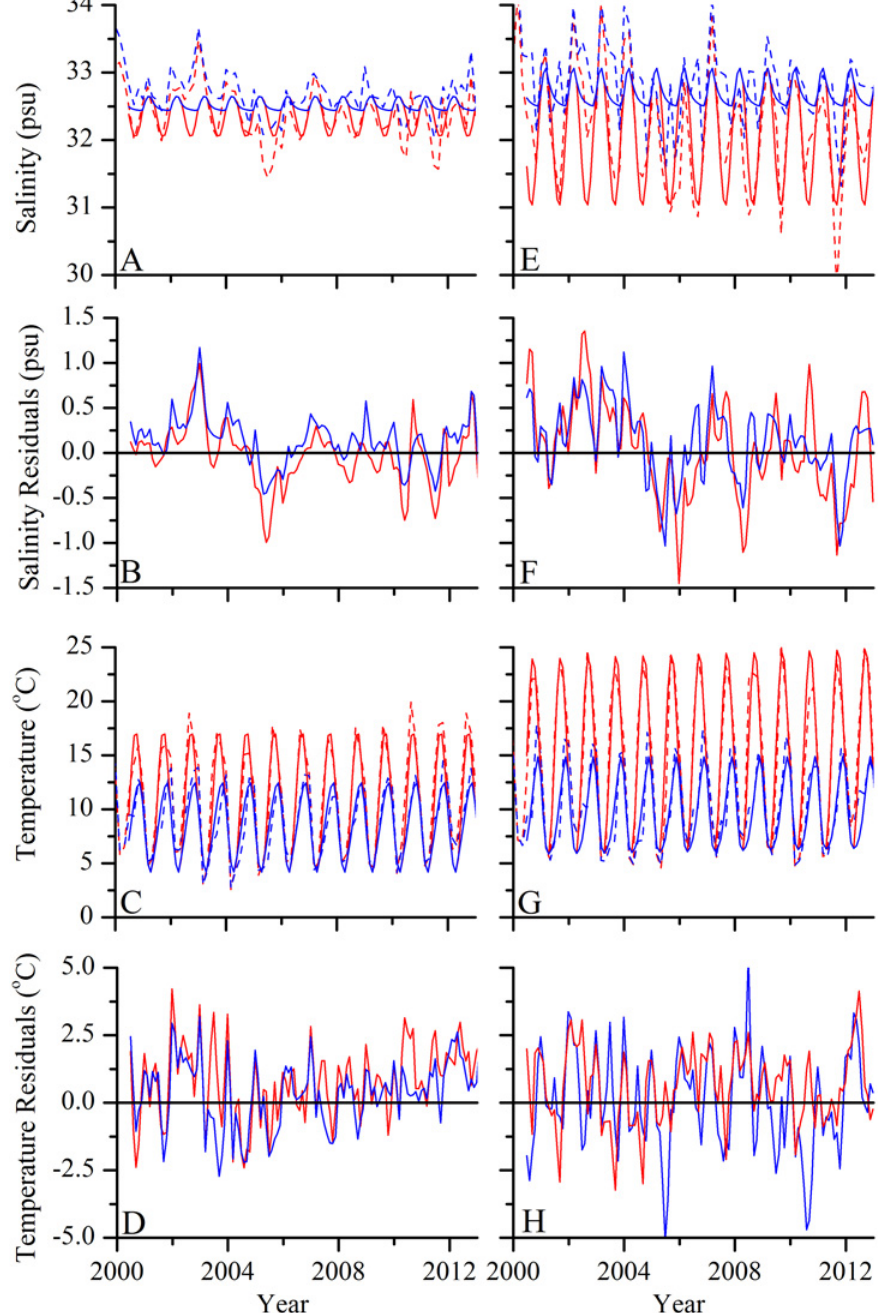
Fig 8. Salinity, salinity residuals, temperature, and temperature residuals from the two box models (solid) calibrated to data collected during bimonthly oceanographic cruises (dashed) within a 1° x 1° area representative of conditions on (A — D) Georges Bank and (E — H) in the Mid-Atlantic. Surface conditions are given in red and bottom conditions are given in blue. Data from NEFSC Oceanography